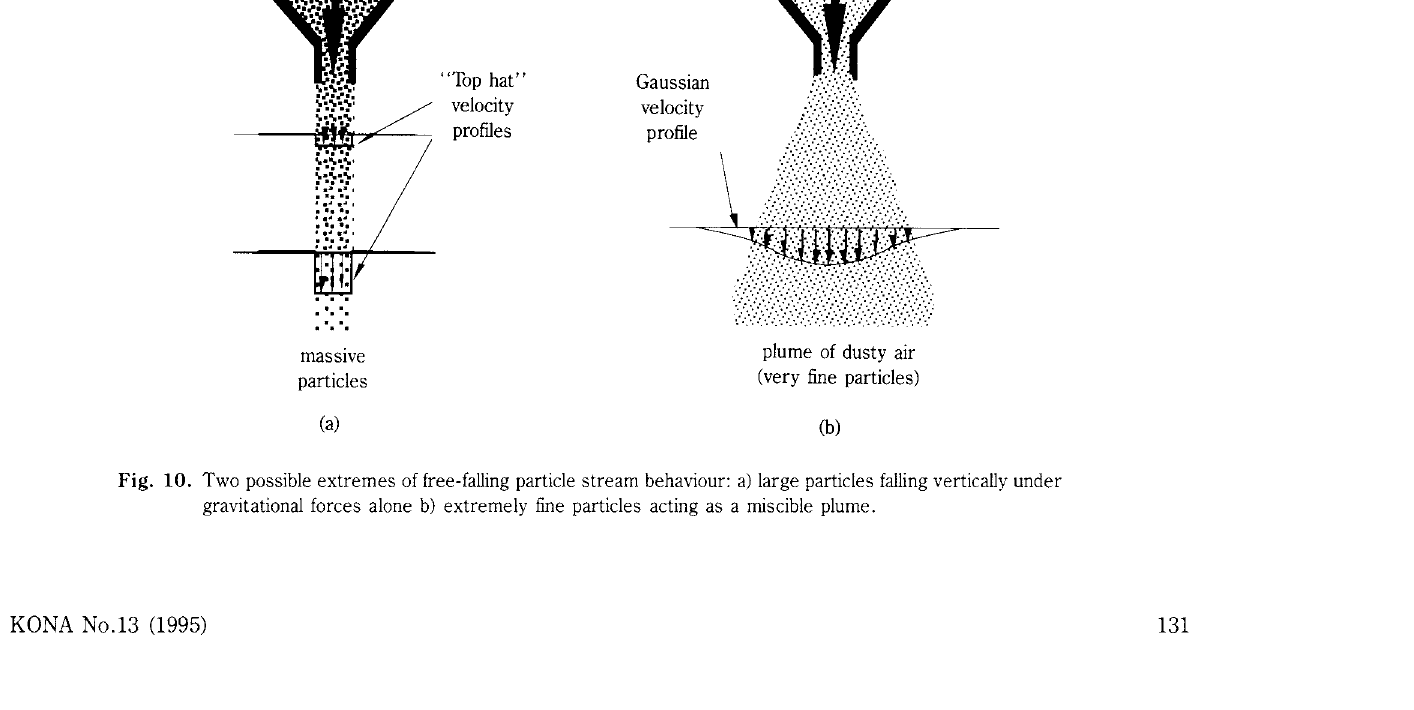
Fig. 10. Two possible extremes of free-falling particle stream behaviour: a) large particles falling vertically under gravitational forces alone b) extremely fine particles acting as a miscible